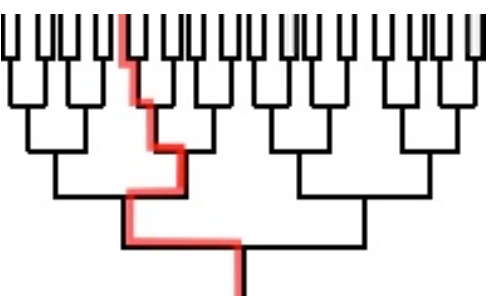
Figure 6. Decision tree. Time starts at the bottom and increases in the vertical direction. Two possible choices are assumed for each